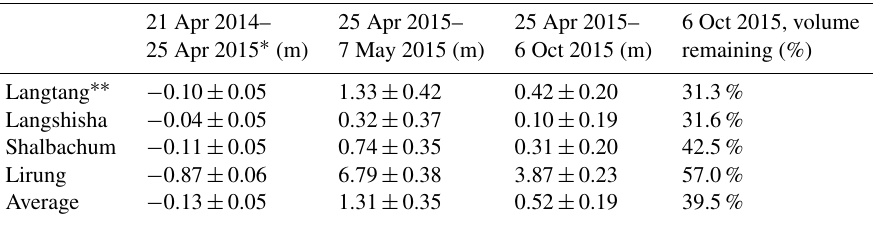
Table 8. Elevation changes of debris-covered glacier tongues due to avalanches triggered by the Nepal earthquake on 25 April 2015. The first three data columns provide the volume changes of avalanche-affected area ( (cid:49)h >5m in May 2015) divided by the total debris-covered area (Table 1).